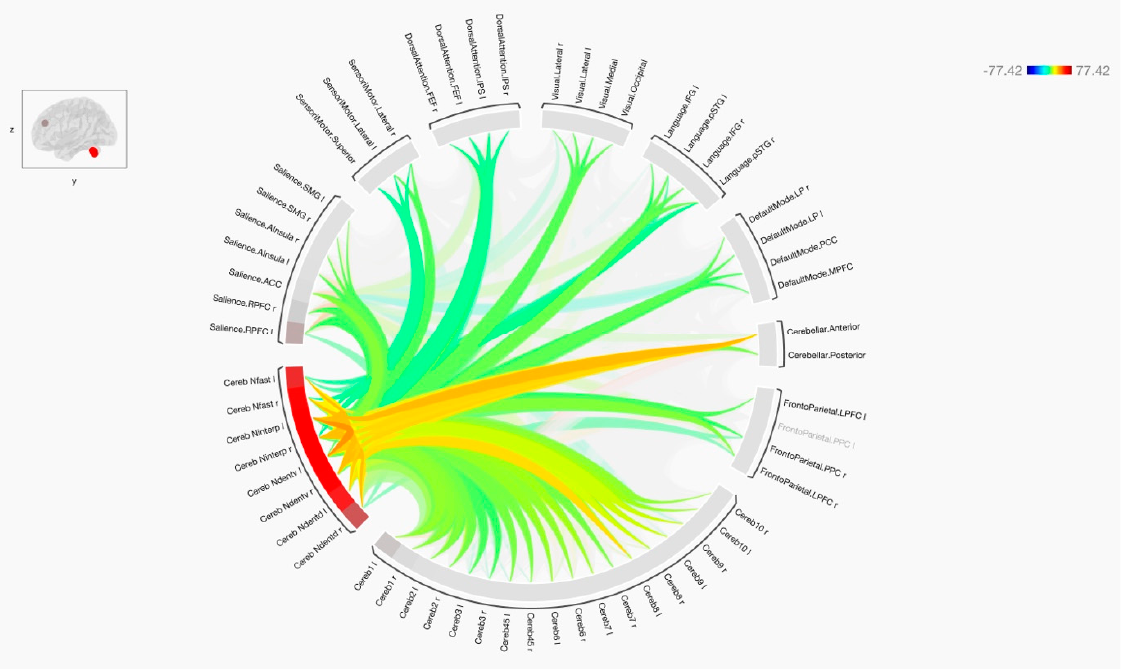
Figure 2. The functional connectivity of the cerebellar nuclei and target networks is shown at the group level. The lines of the connections in red indicate positive connectivity, while blue indicates negative connectivity. The colors of the lines are proportional to statistical strength, and the T-bar is shown in the top right-hand